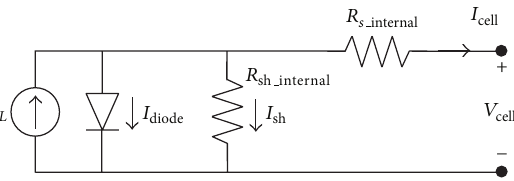
Figure 8: The one diode model for a p-n-junction solar